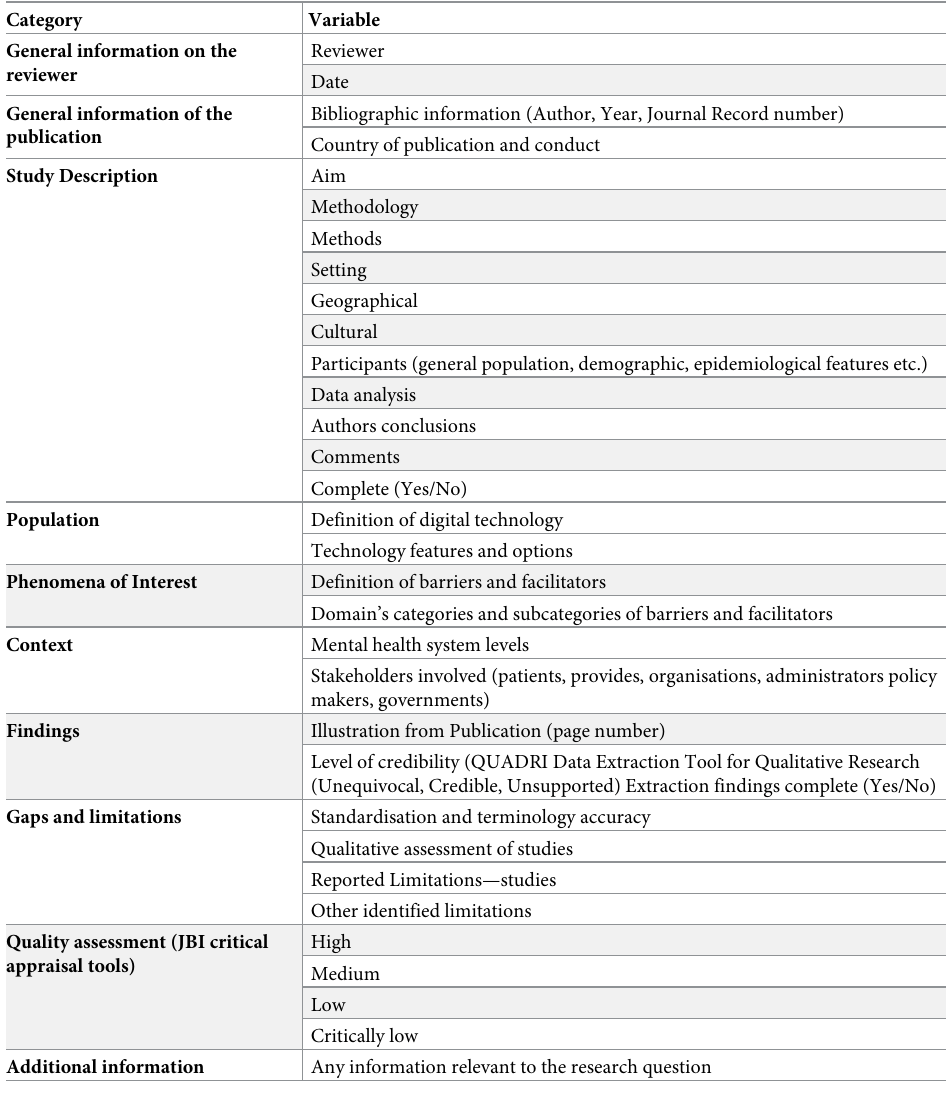
Table 2. Initial data extraction